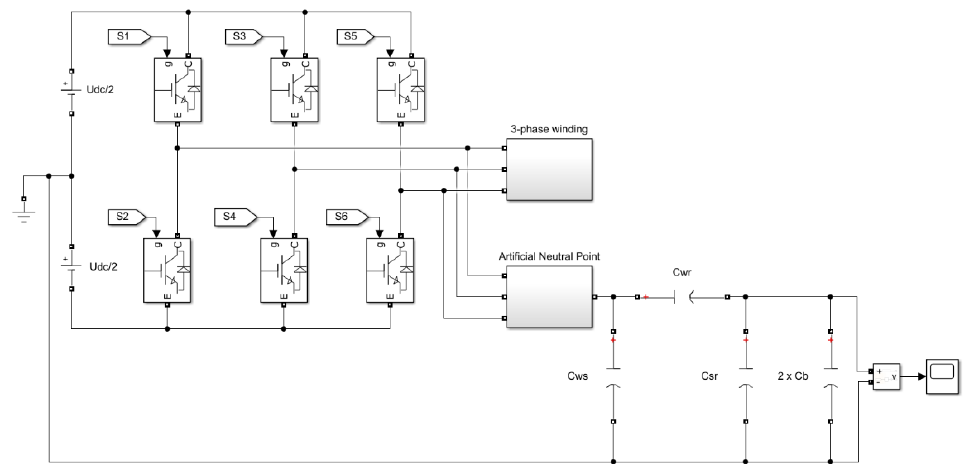
Figure 18. Simulation model with the two-level DC/AC converter.